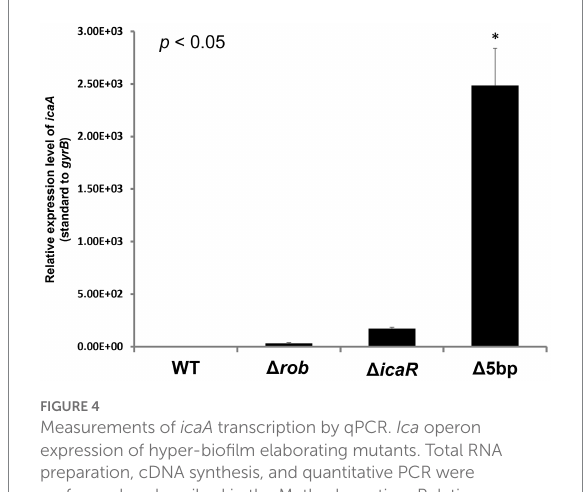
FIGURE 4 Measurements of icaA transcription by qPCR. Ica operon expression of hyper-biofilm elaborating mutants. Total RNA preparation, cDNA synthesis, and quantitative PCR were performed as described in the Methods section. Relative expression level of ica operon; transcript levels in the Δ 5bp, icaR, or rob deletion mutants as compared to those in WT strain FK300 are shown. The expression of gyrB was used for sample normalization. Bars indicate mean values, error bars indicate standard error of the mean ( n = 3). Kruskal-Wallis test results p < 0.05. There were significant differences between all deficient strains and WT. *: p < 0.05 (Mann–Whitney U test). WT; wild type strain